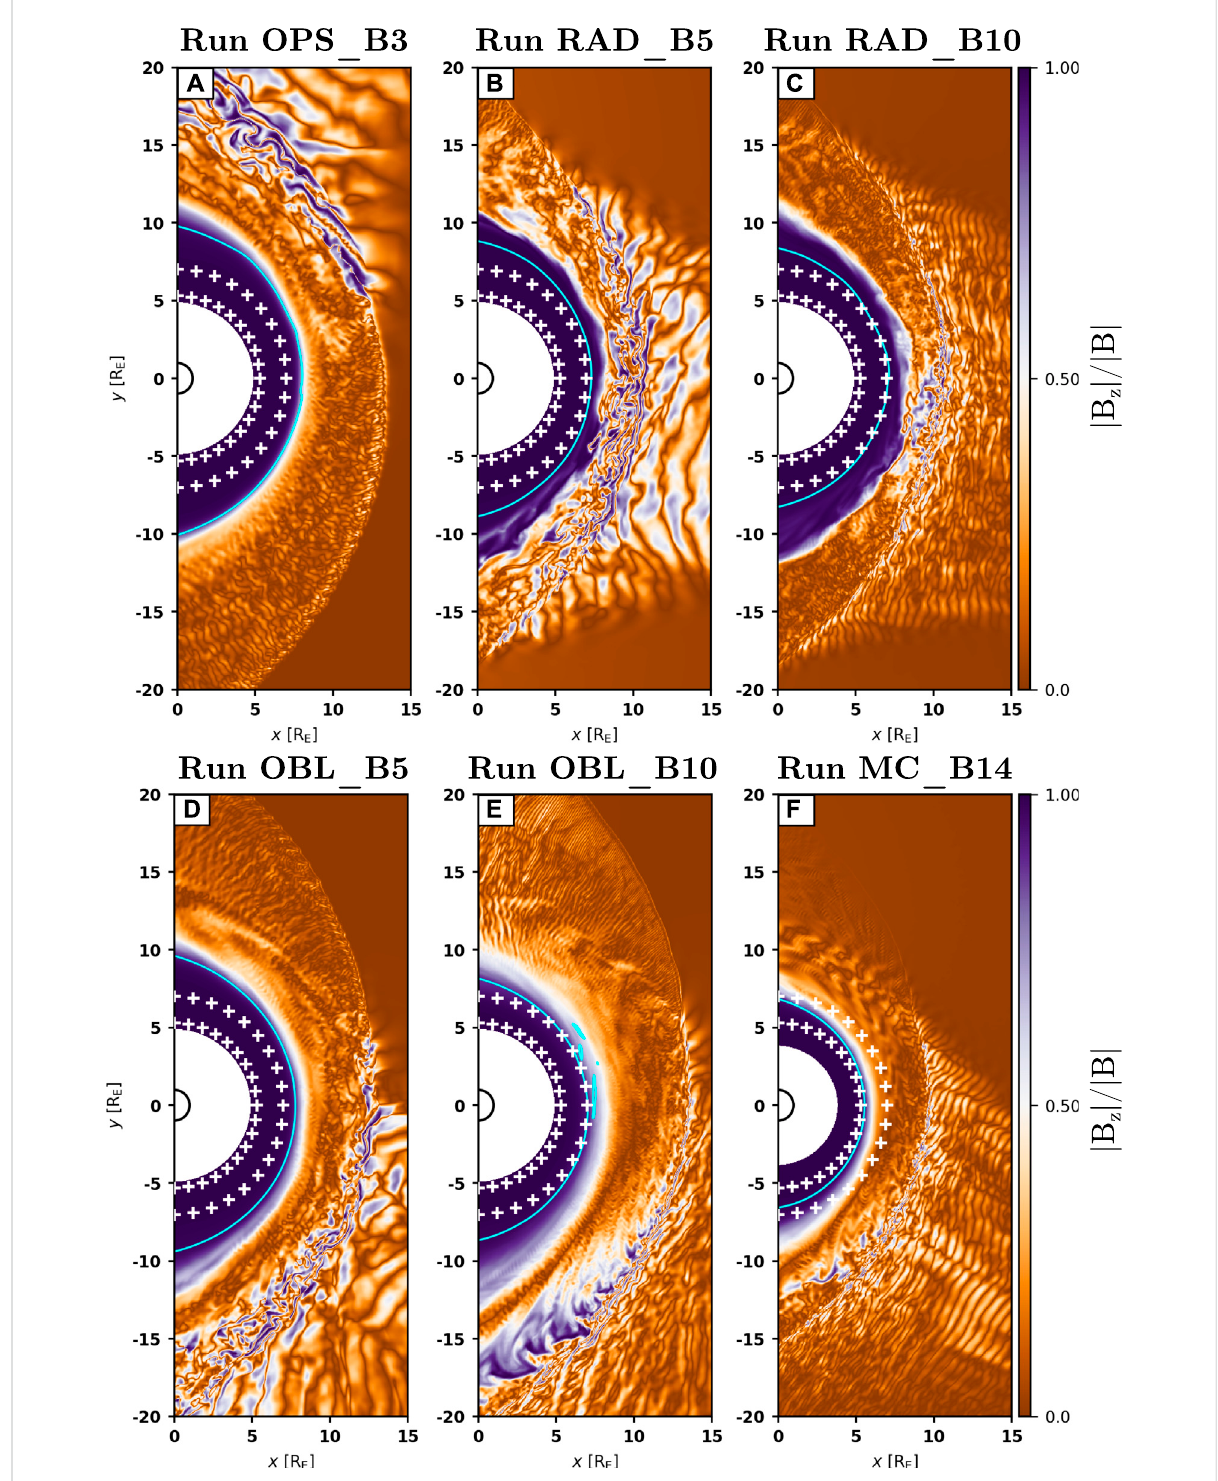
FIGURE 7 Thecolour scheme showsthefractionof B z relativeto thetotalmagnetic fi eldstrength| B z |/| B |at t =425 s.Insidethemagnetosphere,thisratio is close to 1 as the mean magnetic fi eld is predominantly along B z . Outside the magnetosphere, | B z |/| B | highlights strong deviations from the IMF direction, which lies in the xy − plane. The white plus signs show the positions at which the mean compressional wave power was extracted for the top panels of Figure 6. The cyan contour corresponds to < β * > 150s (cid:2) 0 . 28, which approximates the magnetopause position.